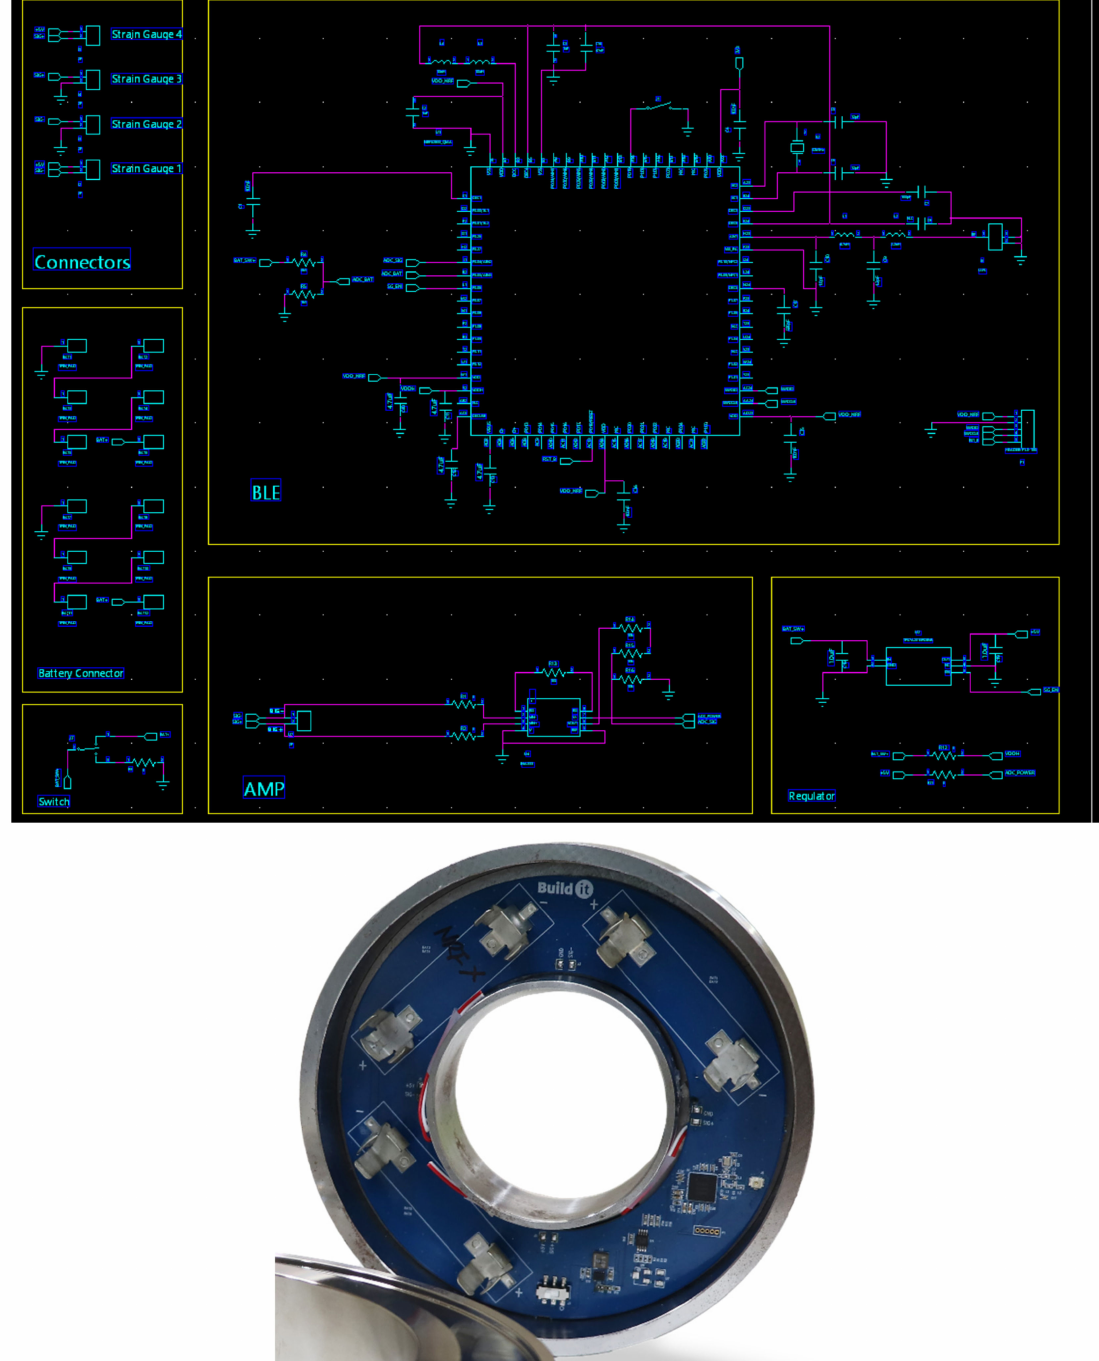
Figure 10. PCB design and circuit